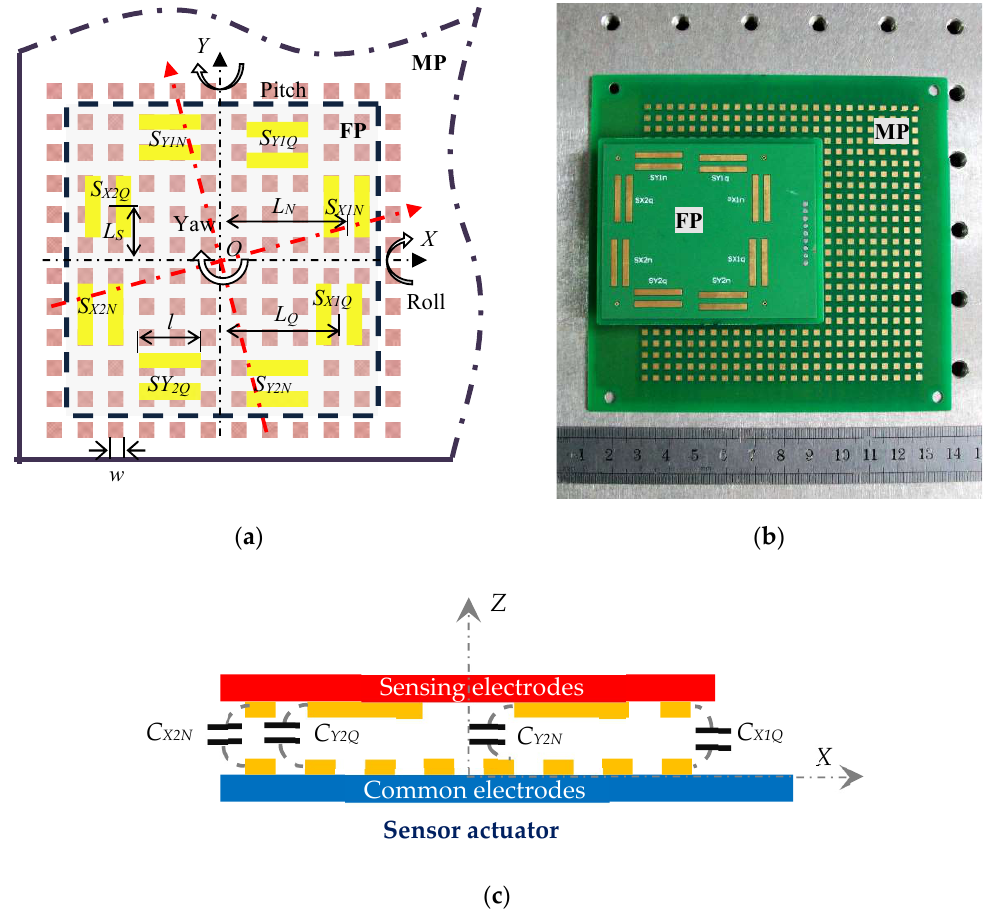
Figure 1. Sensor mechanism of an encoder-like capacitive positioning system. ( a ) Schematic view of a micro capacitive displacement sensor; ( b ) the actual sensor model in PCB prototype; ( c ) the capacitive incremental position sensor in concept.